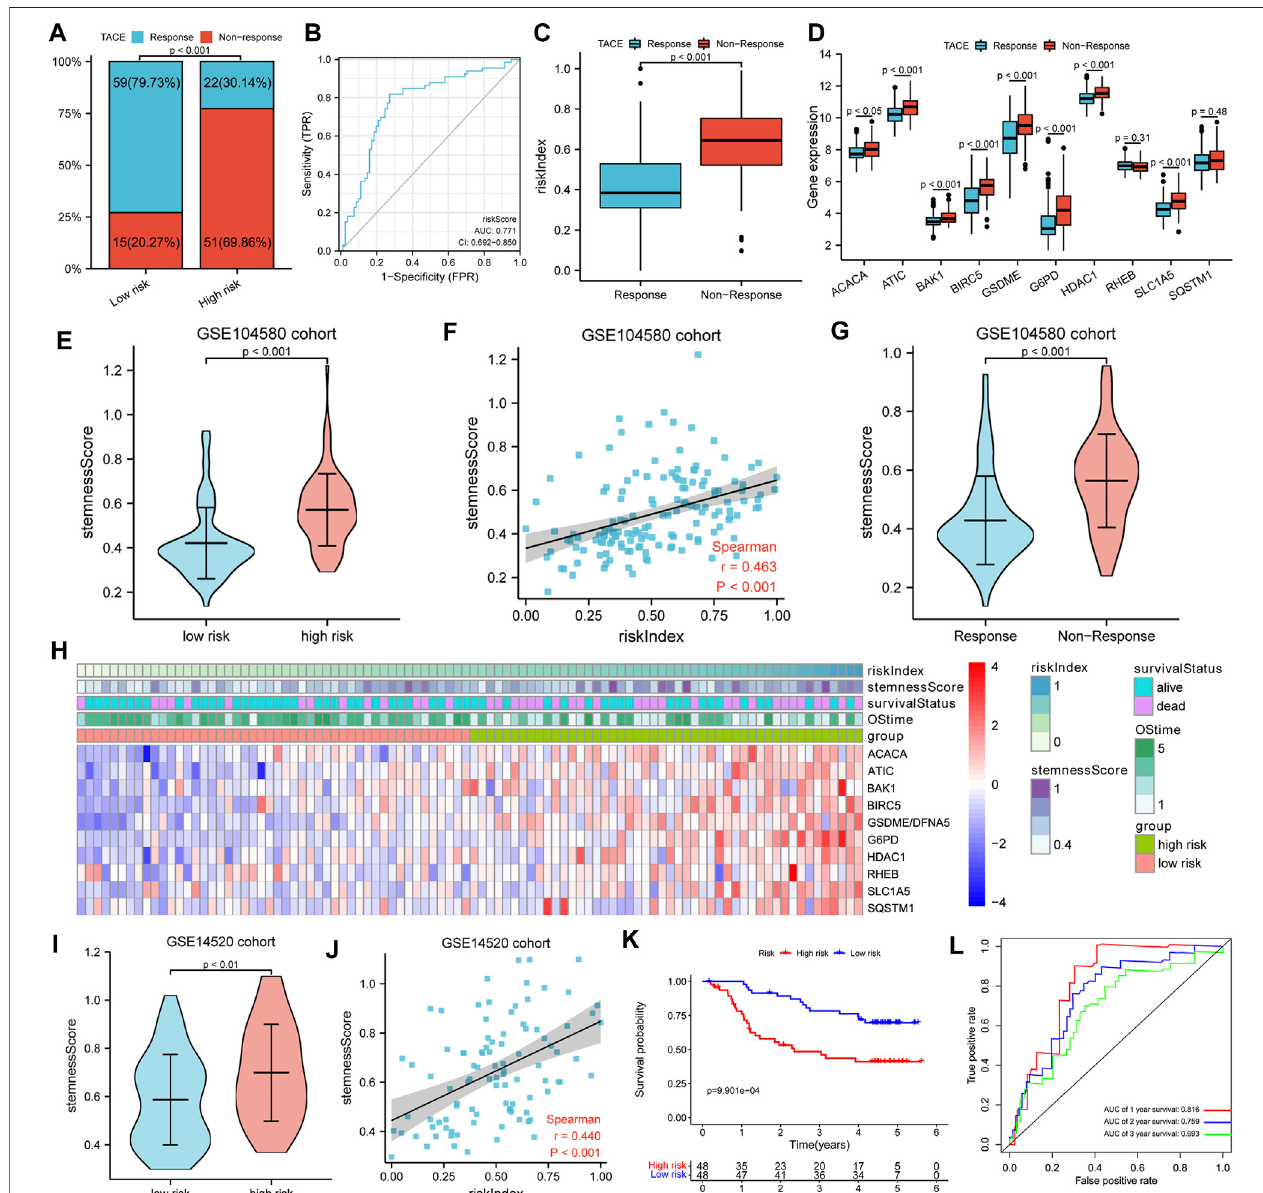
FIGURE7| TACEresponseanalysis. (A) ComparisonofTACEresistancefrequencyinhigh-andlow-riskgroups. (B) ROCcurvesforthepredictiveperformanceof RI for TACE responsiveness. (C,D) The risk index and gene expression between TACE responsive and non-responsive groups. (E,G) The stemness score in different subgroups. (F) Spearman ’ s rank correlation analysis between RI and stemness. (H) The heatmap showed the relationships among risk index, stemness score, 10- modelgeneexpression, andsurvival. (I) TheComparison ofstemnessscoreinhigh-andlow-riskgroups. (J) Spearman ’ srankcorrelation analysisbetweenRIand stemness. (K) K – M curves for OS of patients. (L) AUC of time-dependent ROC curves.